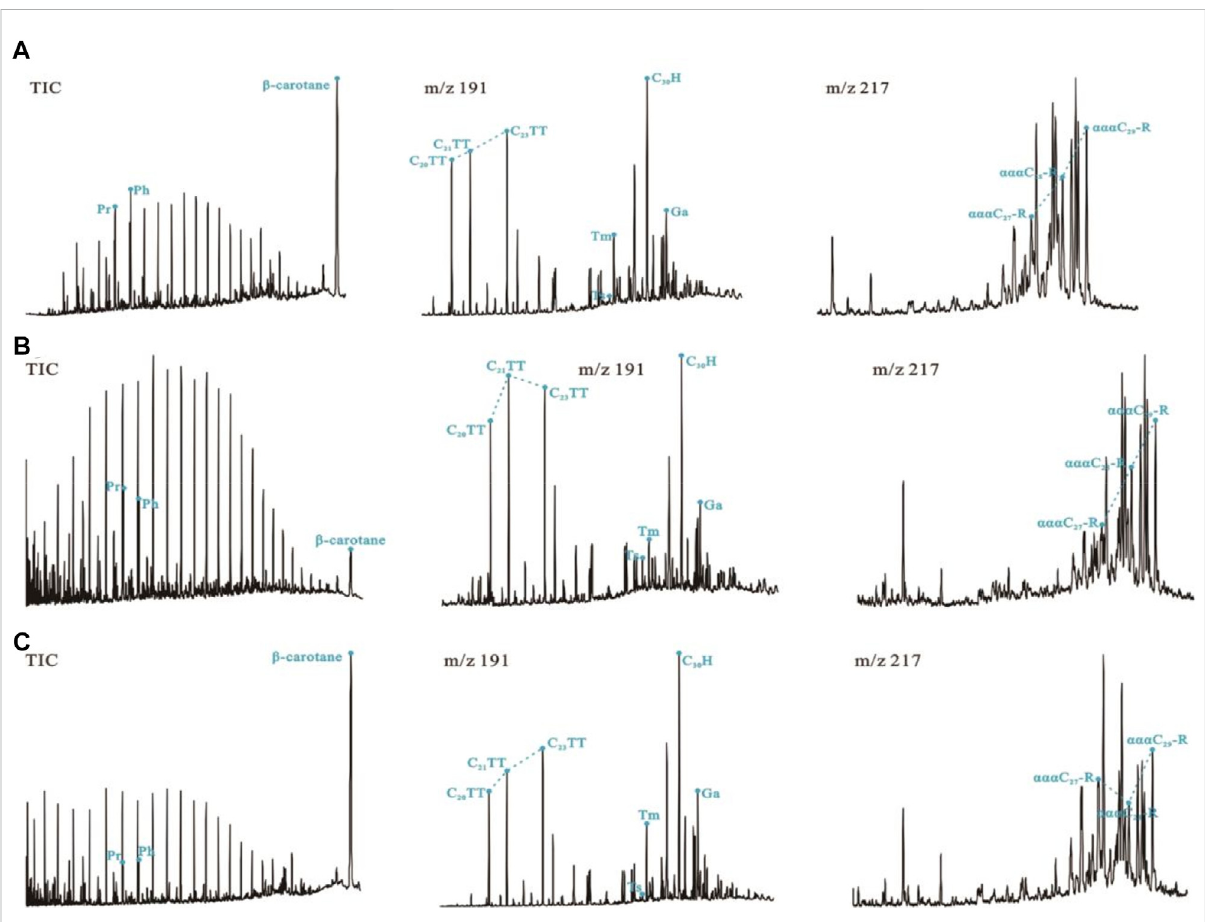
FIGURE 3 Biomarker chromatograms for Carboniferous crude oils in the Penyijingxi Sag. (A) Well Jin102, 1,470 – 1,510 m, Carboniferous, oil; (B) Well Jinlong103, 3,118 – 3,130 m, Carboniferous, oil; (C) Well Jinlong16, 2548 – 2556 m, Carboniferous, oil. Pr is pristane; Ph is phytane; C 20 TT is C 20 tricyclic terpane; C 21 TT is C 21 tricyclic terpane; C 23 TT is C 23 tricyclic terpane; Ts is 18 α (H)-22,29,30-trinorneohopane; Tm is 17 α (H)-22,29,30- trinorhopane;